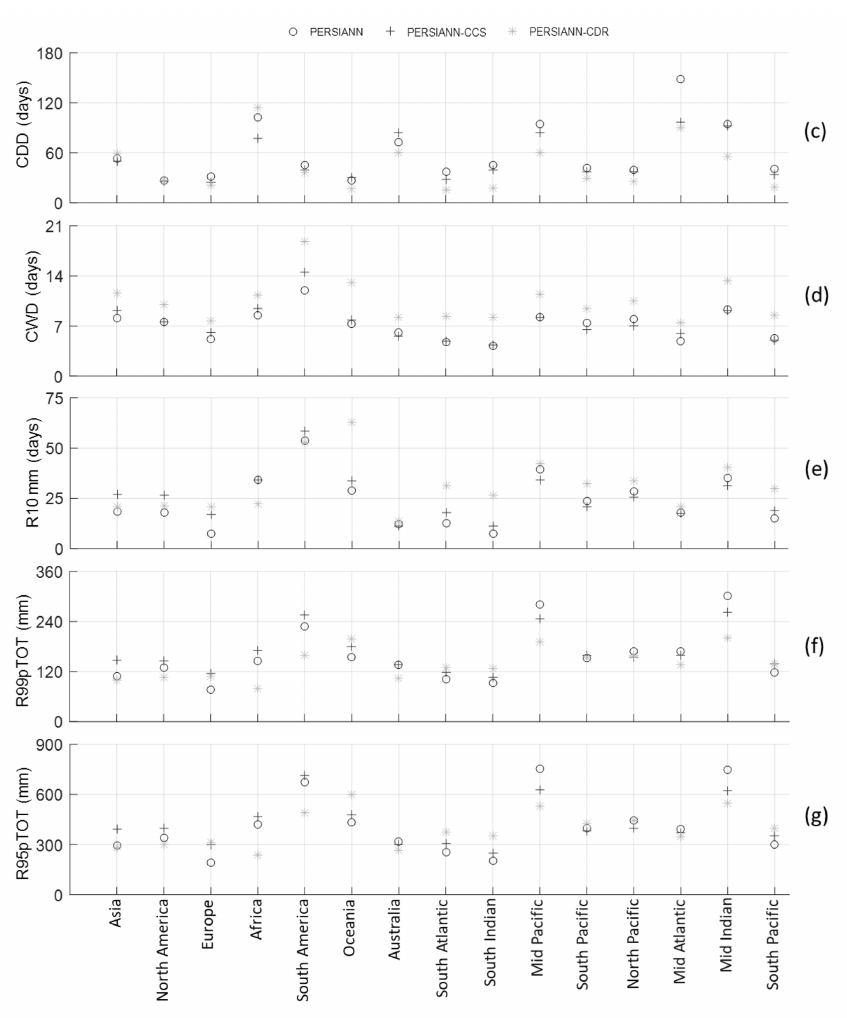
Figure 9. Mean annual precipitation and extreme indices (SDII, CDD, CWD, R10mm, R99pTOT, and R95pTOT) over continents and oceans for PERSIANN, PERSIANN-CCS, and